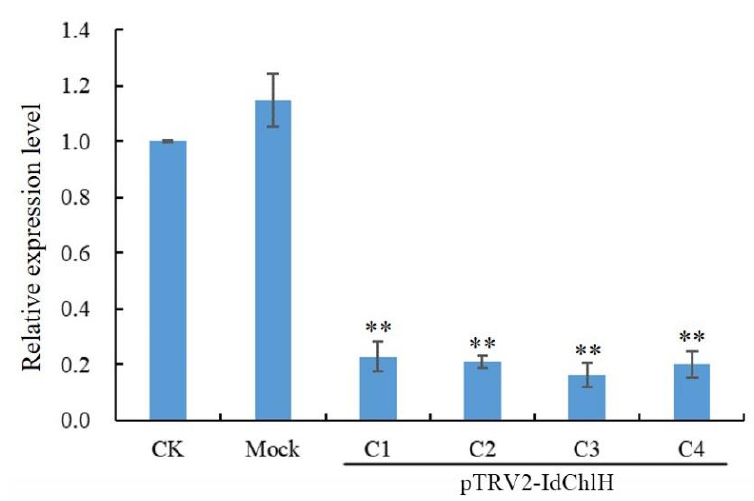
Figure 6. Relative expression levels of IdChlH in the leaves of plants exhibiting the silenced phenotype (pTRV2- IdChlH ), empty vector-infected plants (Mock), and control plants (CK). The error bars represent the ± standard error of three replicates. Asterisks indicate statistically significant differences according to Duncan’s multiple range test (** p < 0.01).